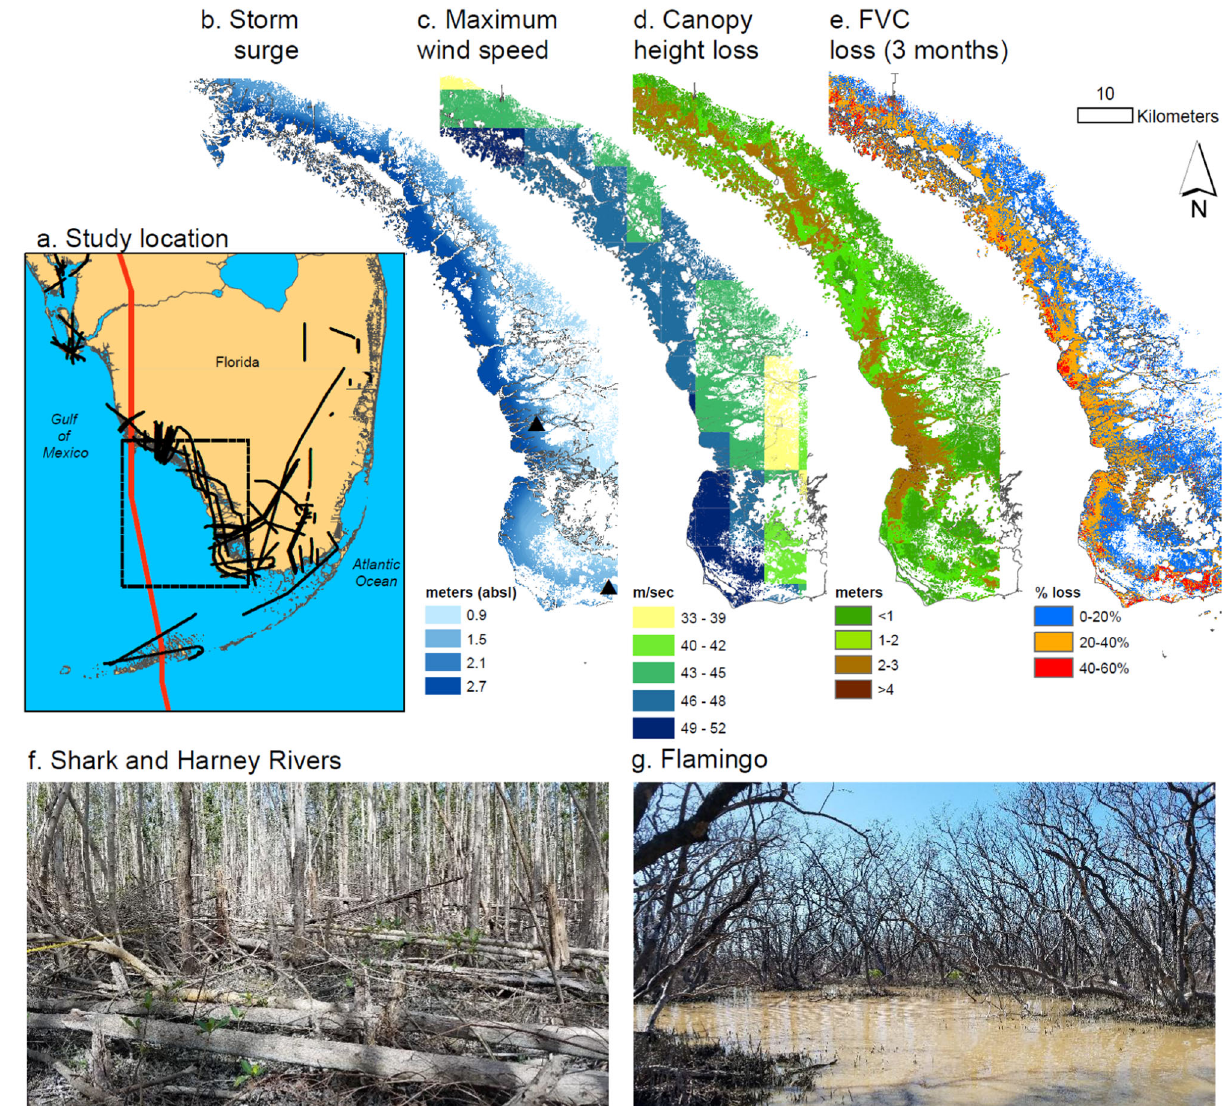
Fig. 1 Tall mangroves in southwest Florida experienced the greatest canopy height losses from strong winds but storm surge and hydrologic barriers led to mangrove dieback in poorly-drained semi-enclosed inland areas for mangroves in all forest height classes. a Track of Hurricane Irma is highlighted in red. NASA G-LiHT lidar coverage is outlined in black. b Modeled storm surge from the Coastal Emergency Risk Assessment. c Maximum hourly wind speeds during Hurricane Irma from the Goddard Earth Observing System, Version 5 model. d Estimated canopy height losses using airborne lidar and high-resolution satellite stereo imagery. e Loss of fractional vegetation cover (FVC) after Hurricane Irma using pre- and post-hurricane Landsat imagery. f Photo collected January 2018 in lower Harney River Estuary. g Photo collected December 2018 in Flamingo. Photo locations are shown in ( b ) as